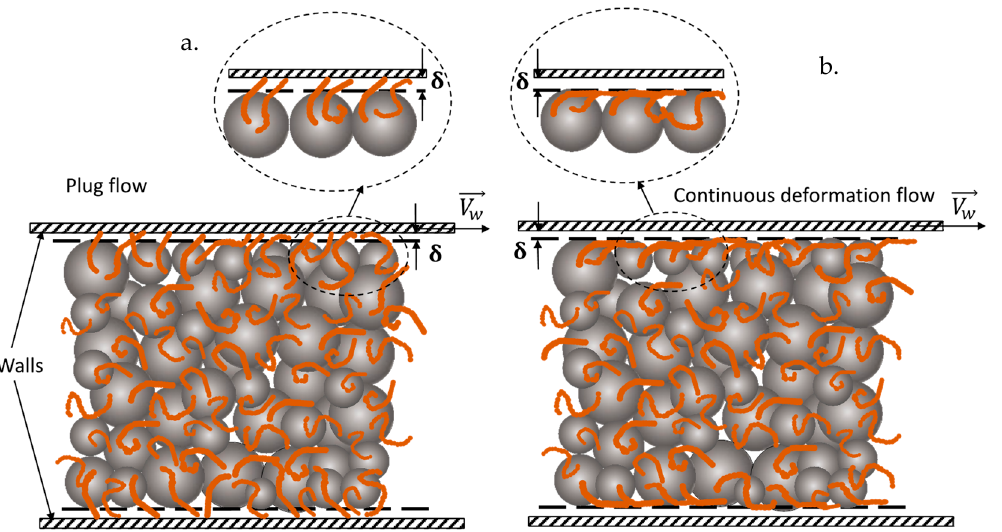
Figure 9. Hypothetical explanation of the differences in the shear viscosity of the fluid at the apparent slip layer, i.e., ( a ) penetration of the PAA chains into the slip layer for the plug flow region and ( b ) apparent slip layer free of particles and PAA chains for the continuous deformation region.